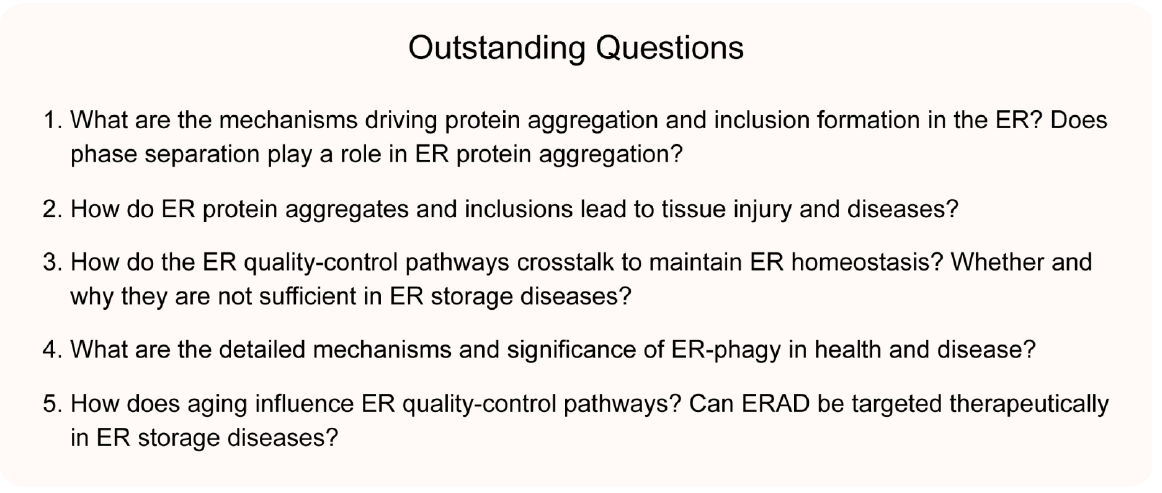
Figure 2. Representative challenging questions related to ER protein quality-control pathways, protein aggregation, and diseases.